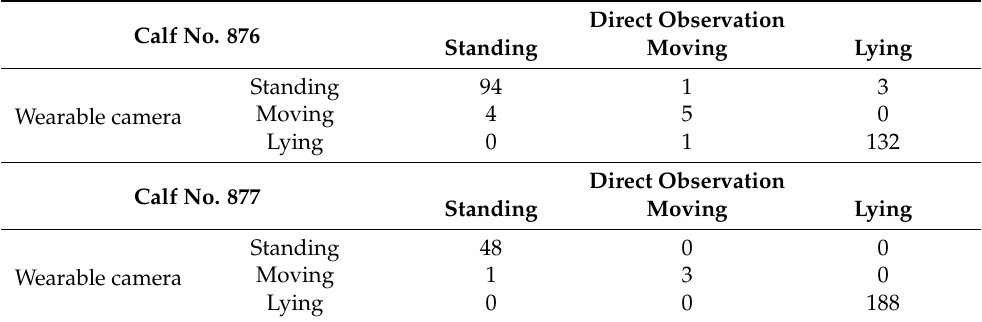
Table 4. Differences between wearable camera observation and direct observation per posture for each